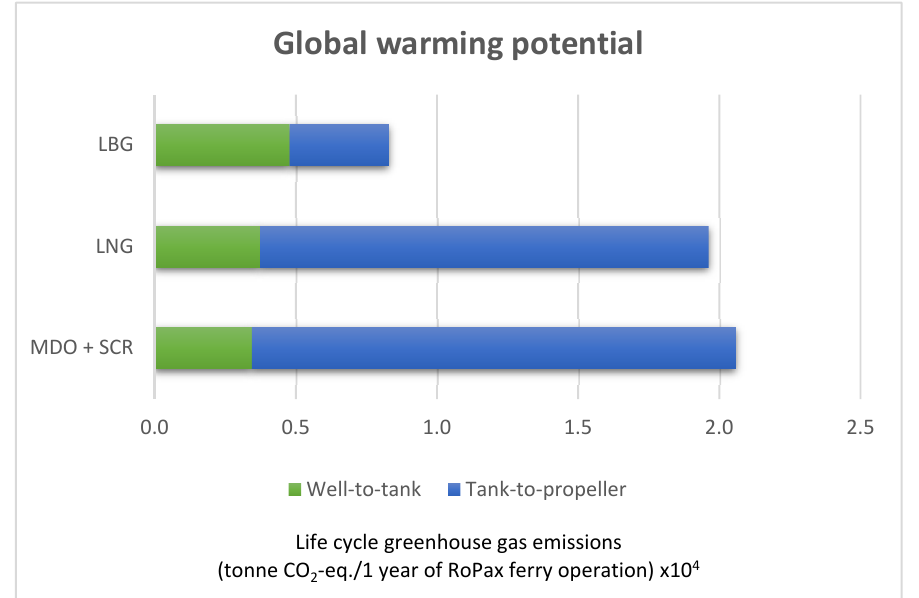
Figure 2. Life cycle GWP 100 for the compared alternatives divided into well to tank (WTT) and termed tank to propeller (TTP) phases.